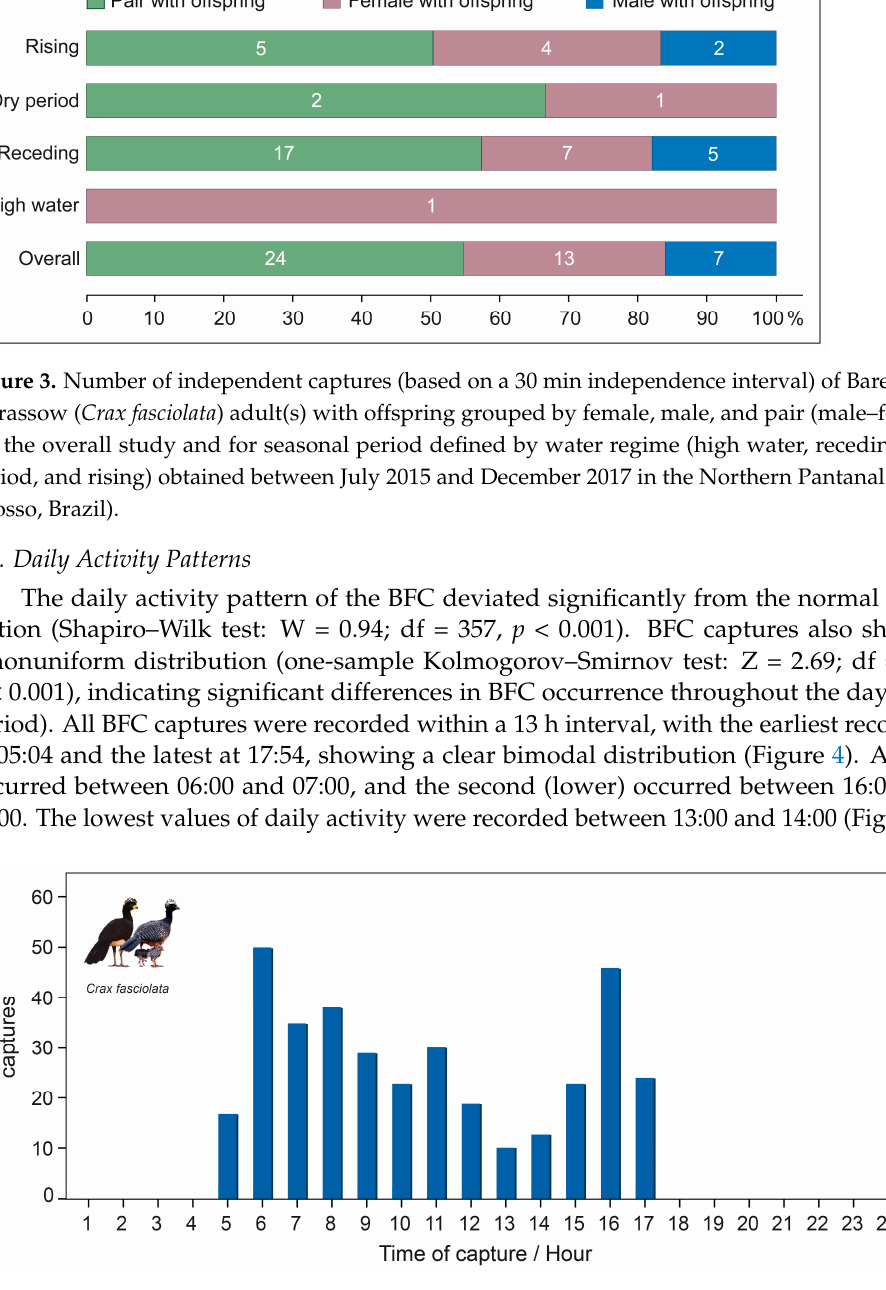
Figure 4. Number of independent captures of Bare-faced Curassow ( Crax fasciolata ) (based on a 30 min independence interval) obtained in the Northern Pantanal (Mato Grosso, Brazil) from July 2015